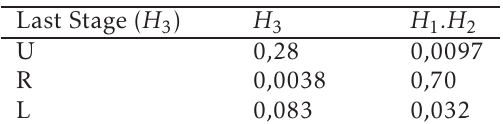
) for different 1 .H 2